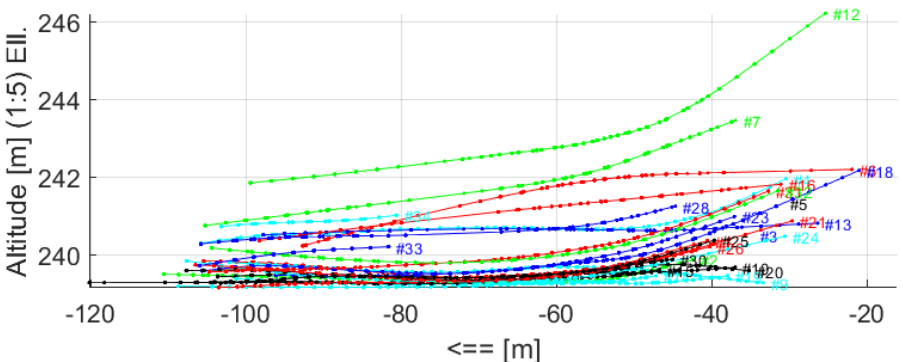
Figure 19. Altitude profiles of 29 landing airplanes from Test #2.